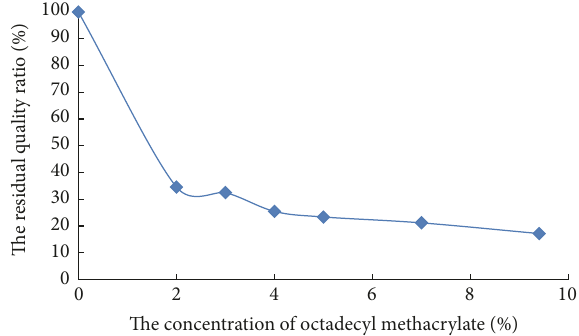
Figure 4: The residual quality ratio of octadecyl methacrylate- acrylamide-N,N 󸀠 -bis(acryloyl)-cystamine hydrogel (the concentra- tion of octadecyl methacrylate (a) 3%, (b) 4%, (c) 5%, (d) 7%, and (e)